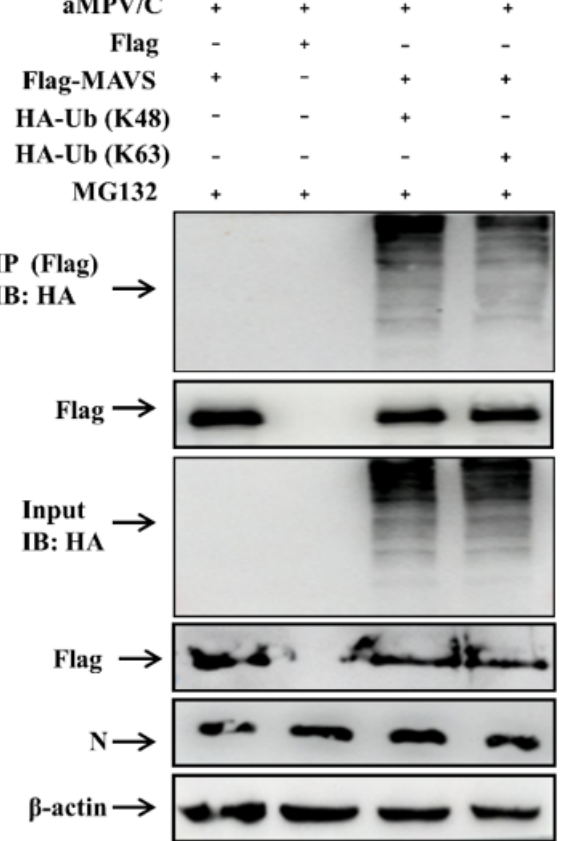
Figure 4. MAVS mainly undergoes K48-linked ubiquitination. Vero cells were co-transfected with Flag-MAVS and HA-Ub (K48) or HA-Ub (K63). After 6 h transfection, the cells were infected with aMPV/C (MOI = 0.5) for 48 h in the presence of MG132, and analyzed using IP with anti-Flag antibody or Western blot with anti-HA antibody. In addition, Flag, HA and β -actin in aMPV/C-infected cells detected by immunoblotting were used as an input control and an internal loading control, respectively. aMPV/C infection was verified with antiviral N antibody.